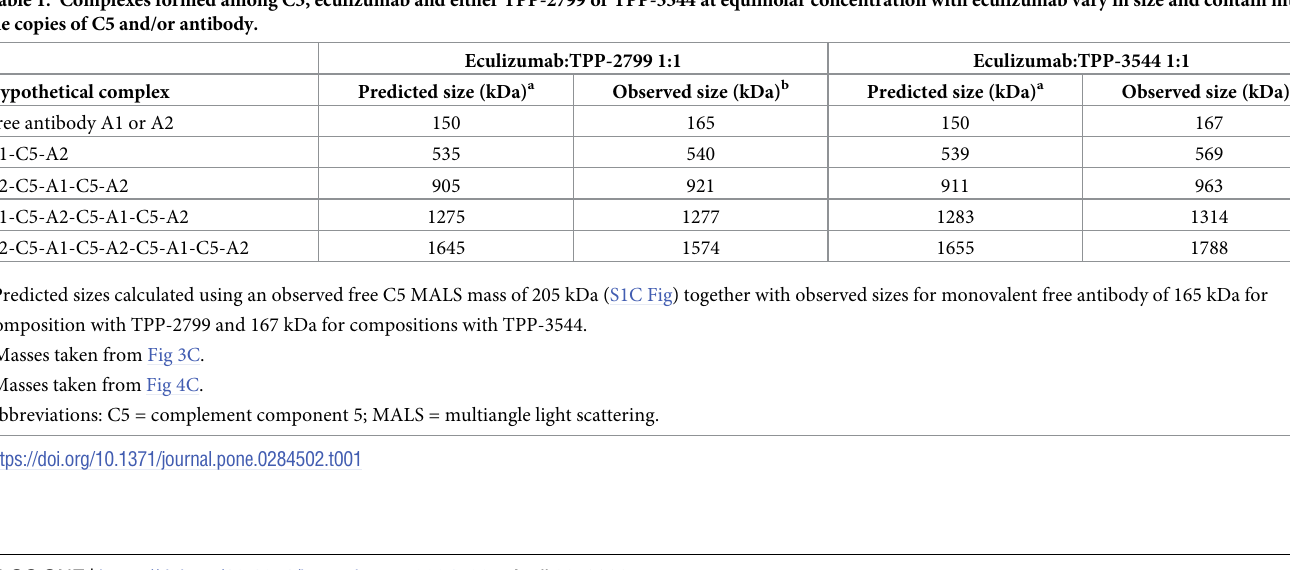
Table 1. Complexes formed among C5, eculizumab and either TPP-2799 or TPP-3544 at equimolar concentration with eculizumab vary in size and contain multi- ple copies of C5 and/or antibody.